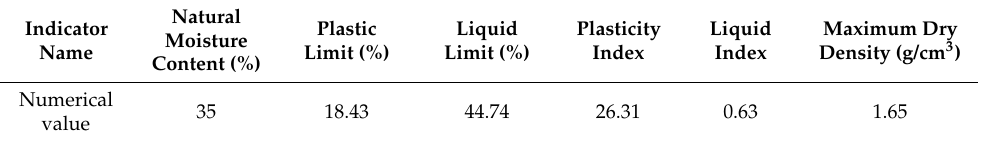
Table 1. Physical index of soil.